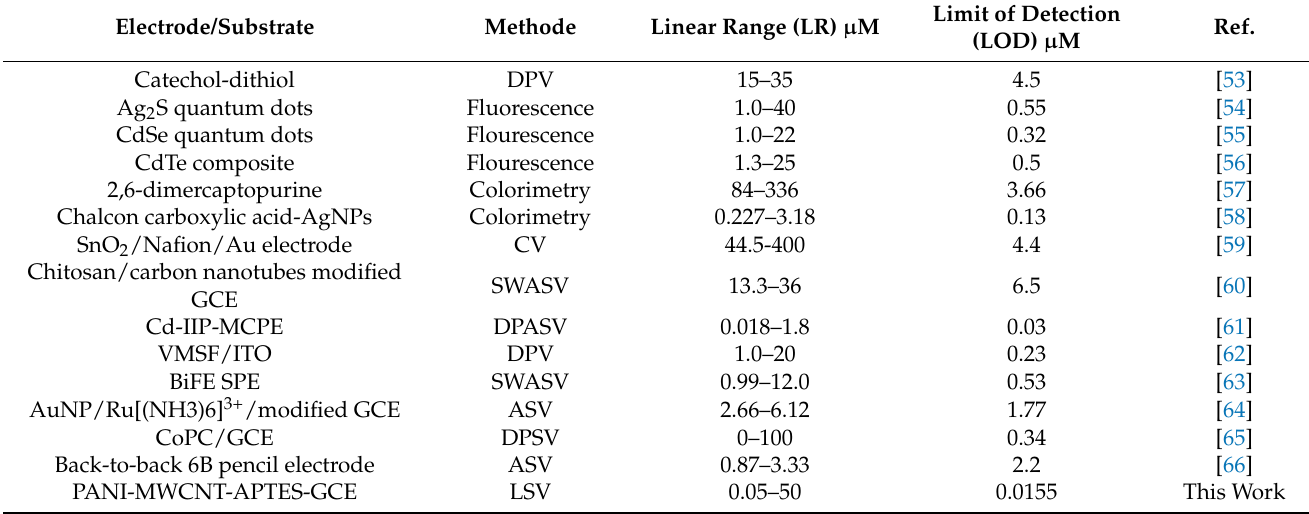
Table 2. Comparison of the developed method in this study with the selected existing